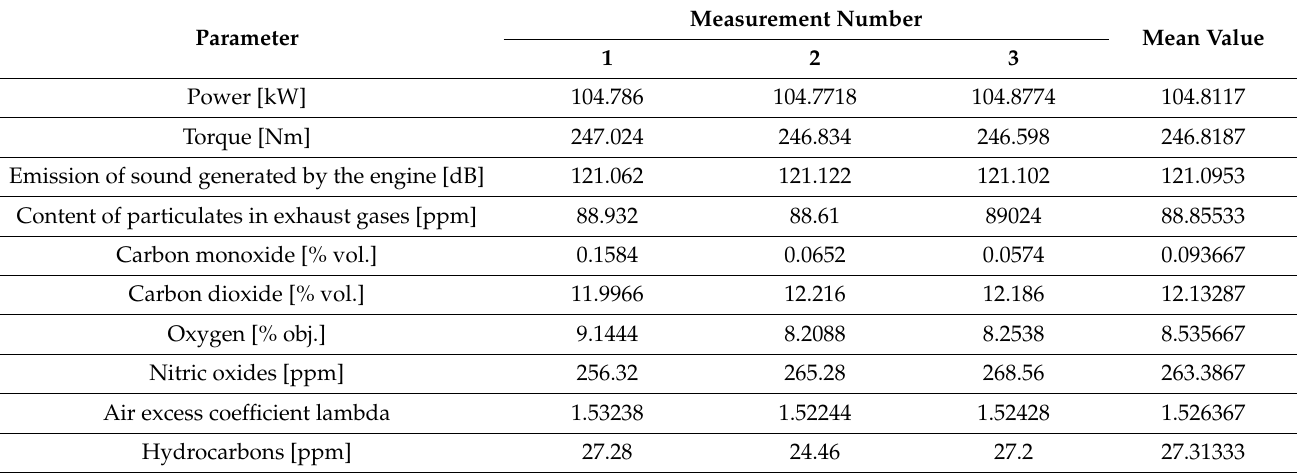
Table 8. Average measurement results for mixture V.